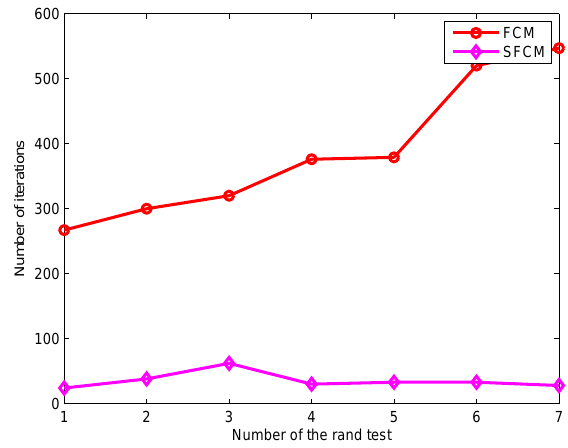
Figure 2. Comparison of the number of